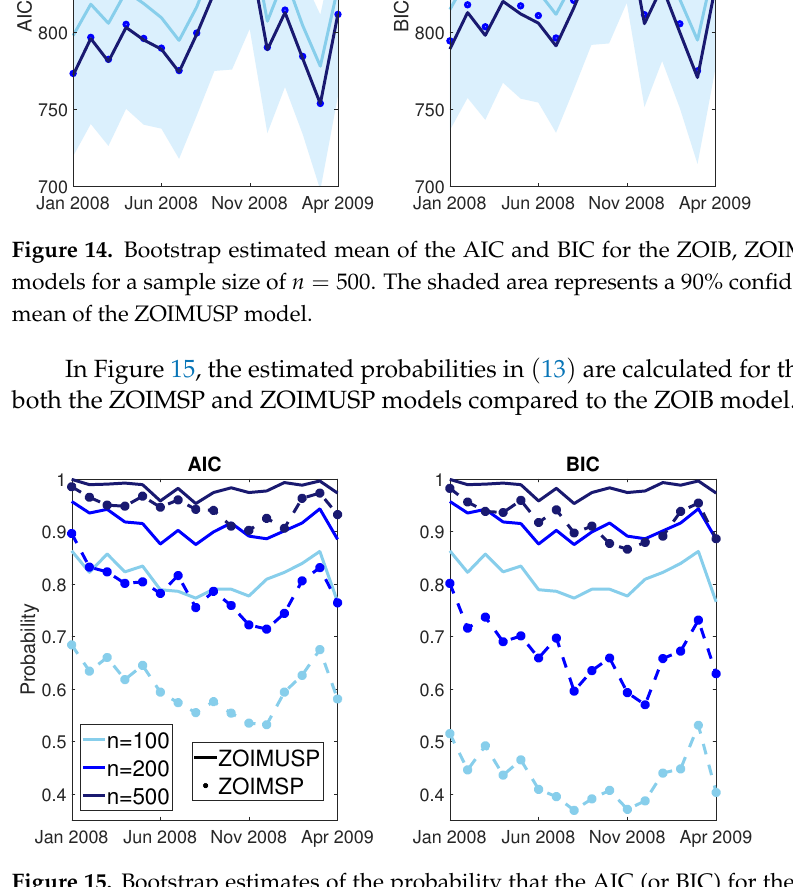
Figure 15. Bootstrap estimates of the probability that the AIC (or BIC) for the fitted ZOIMSP and ZOIMUSP models is less than the AIC (or BIC) of the fitted ZOIB model over several months and for sample sizes of n = 100,200, and